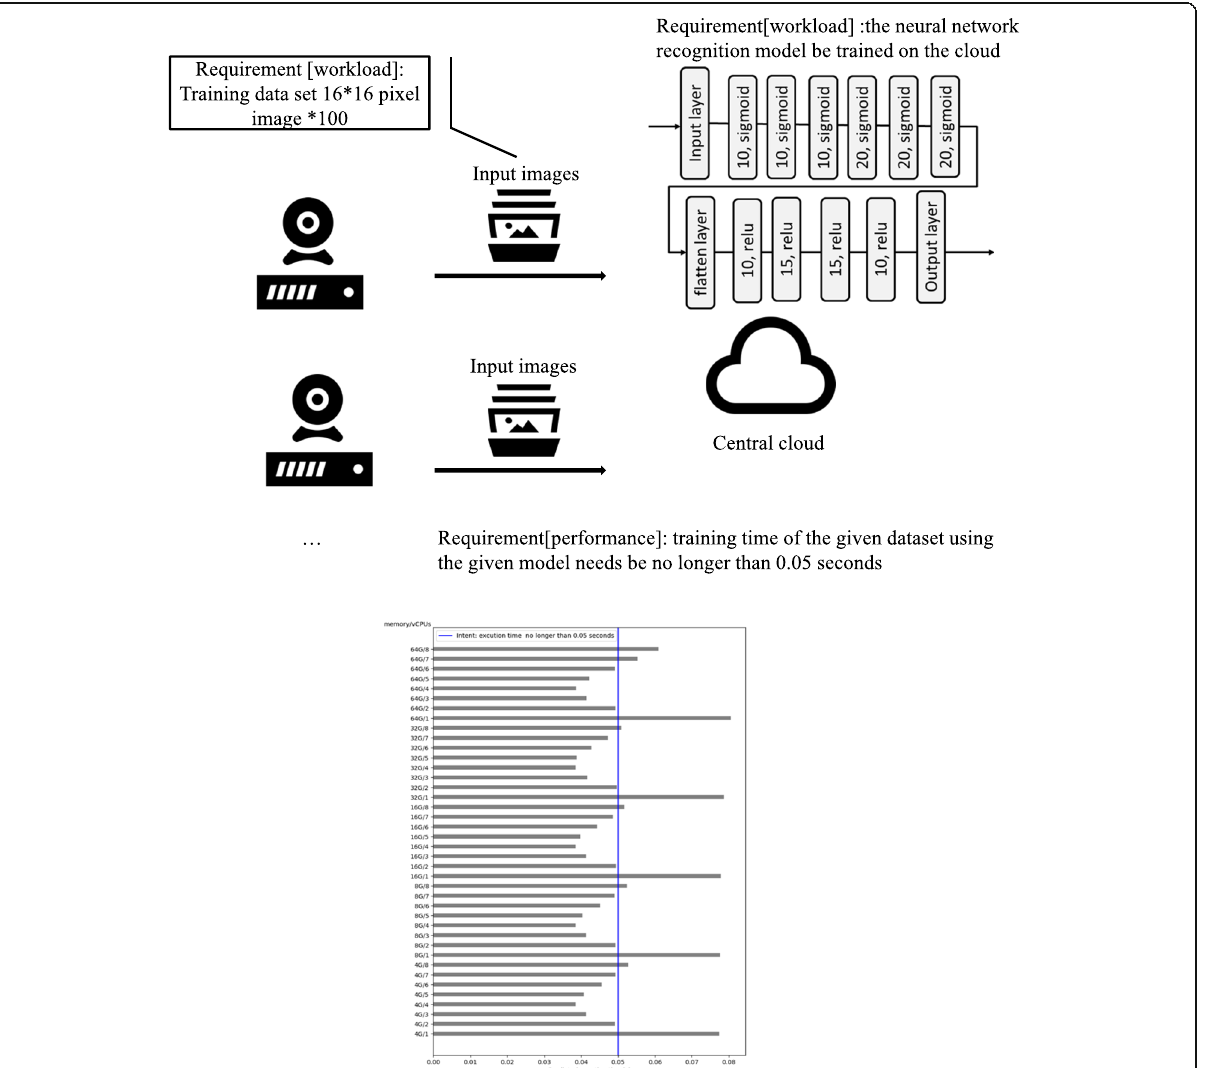
Fig. 7 An intent example of the application engineer for the sensor-cloud system (above) and the performance inference and Resource Design for the intent example by